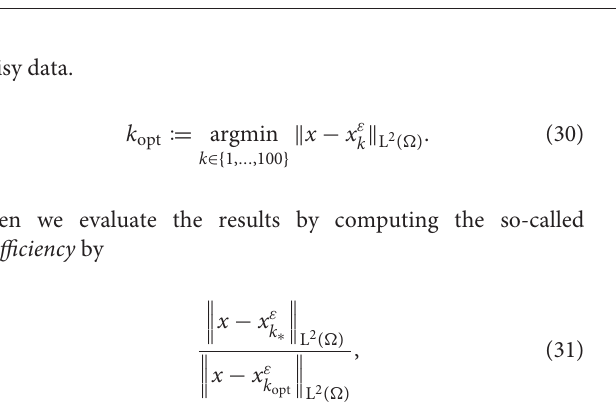
FIGURE 3 | Reuter grid (Left) and scattered grid (Right) . The values of the data points in the red area contain an N2S of 5 % and the values of the data points in the blue area an N2S of 1 % for the local noise scenario.